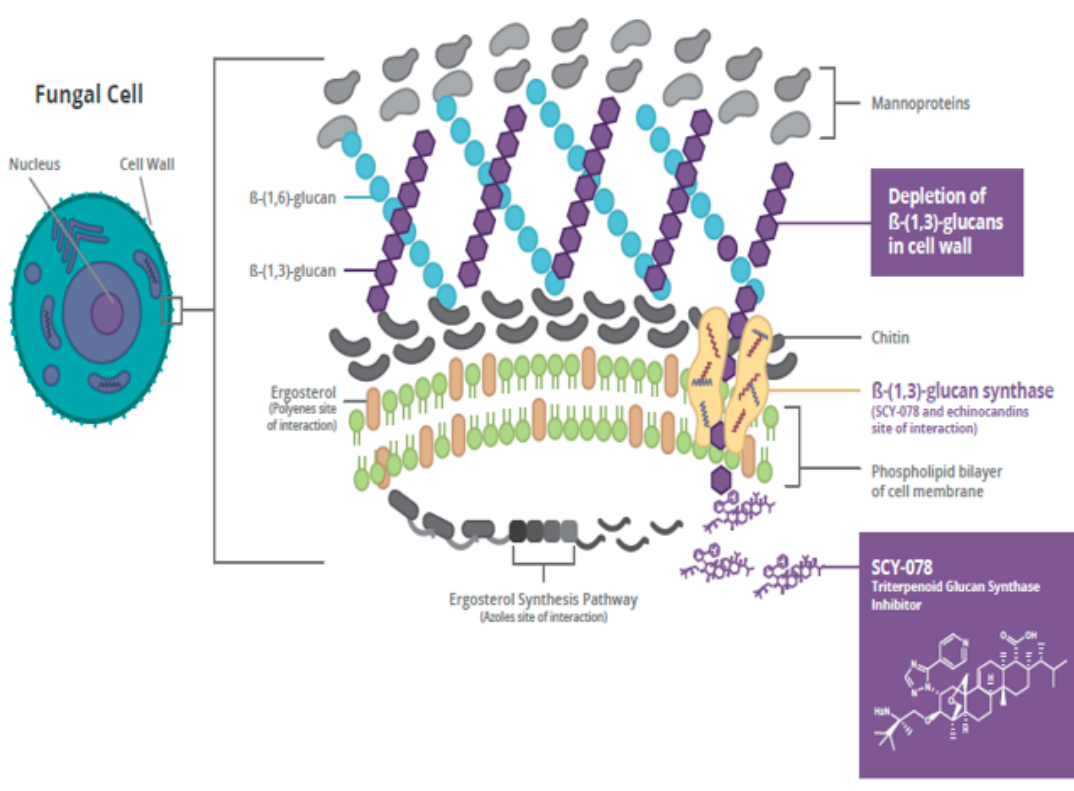
Figure 2. Mechanism of action for